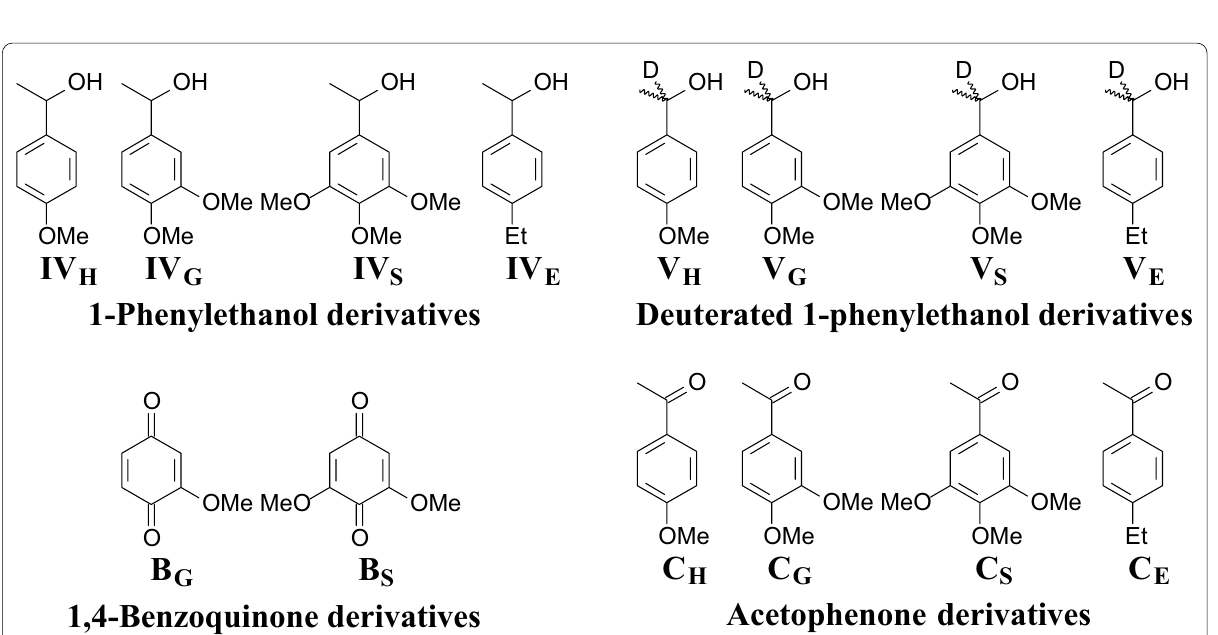
Fig. 3 Structure of monomeric C 6 -C 2 -type compounds used as starting materials and quantified exclusive major reaction products in this